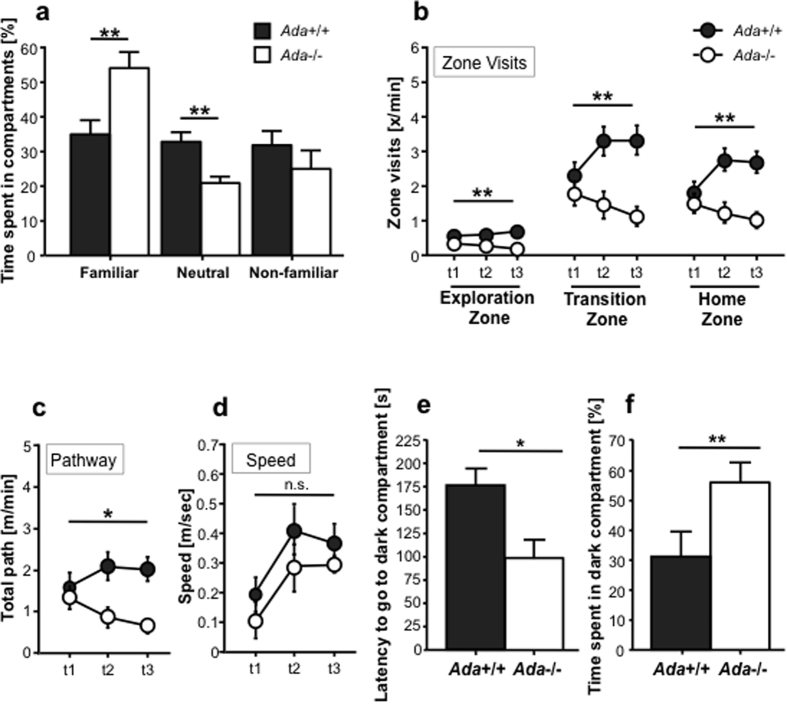
Behavioral differences between Ada+/+ and Ada−/− mice.(a) Olfactory discrimination task at PND20 between familiar, neutral and non-familiar compartments for Ada+/+ (n = 20) and Ada−/− (n = 24) mice as percentage of time spent in each compartment. Values represent the mean + SEM; **p < 0.005. (b) Zone visits during Open Field test of Ada+/+ (n = 25) and Ada−/− (n = 20) mice at PND15 (t1-3). (c) Total pathway and (d) speed during Open Field test of Ada+/+ (n = 25) and Ada−/− (n = 20) mice at PND15 (t1-3); n.s. = non significant. (e) Latency to go to the dark compartment during the dark and light test at PND15; ADA (n = 29) and Ada−/− (n = 33); *p < 0.05. (f) Time spent in the dark compartment during the dark and light test at PND 15; ADA (n = 29) and Ada−/− (n = 33); **p < 0.005.